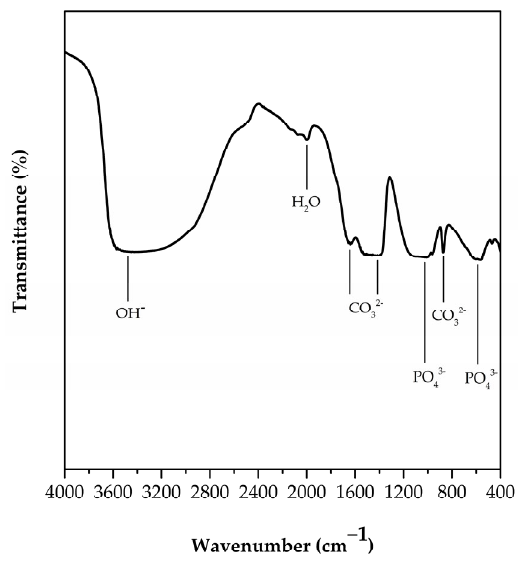
Figure 3. FTIR spectrum of FSp.